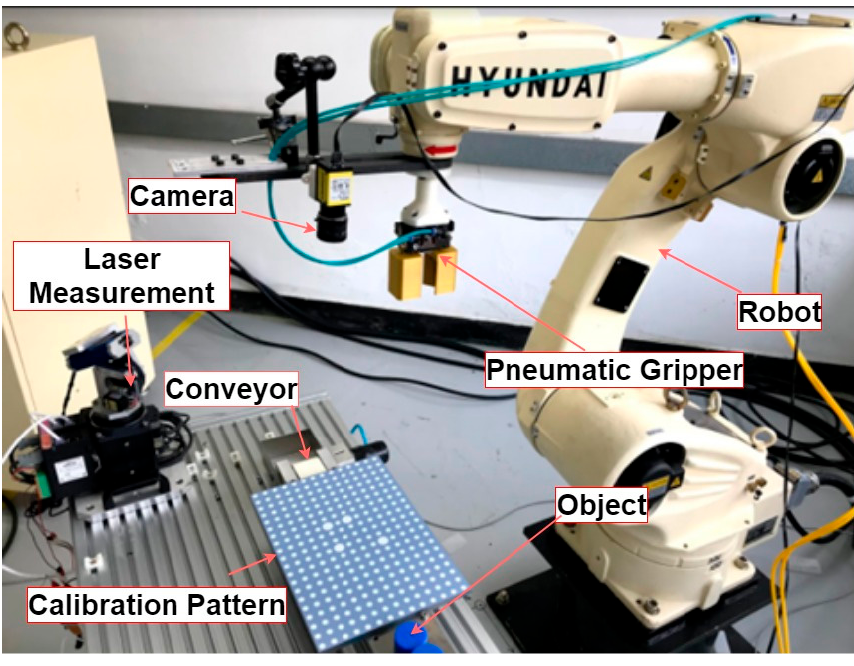
Figure 10. Setup for training robot.